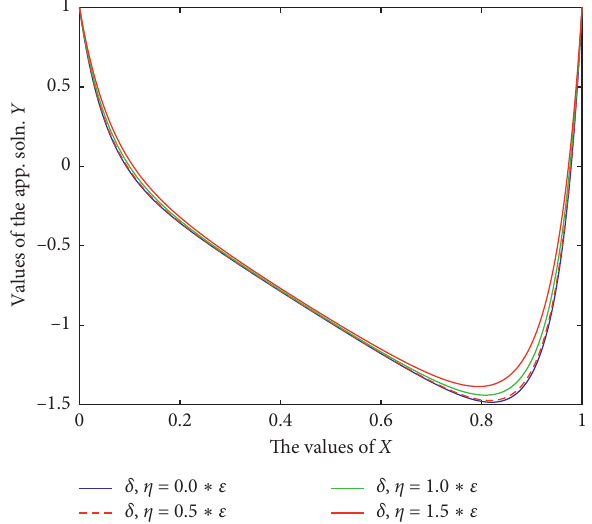
Figure 4: Plot of the solutions of Example 2 for ε � 0.1 and N � 256.